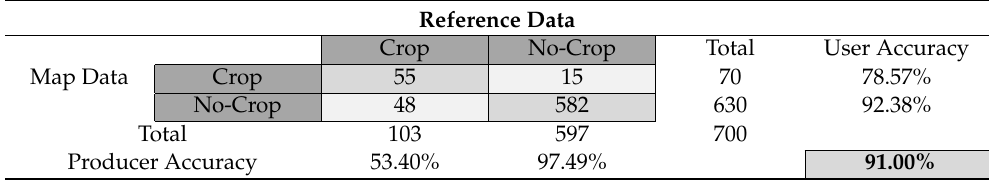
Table 7. The error matrix generated using balanced reference samples generated in crop buffer zone 1.